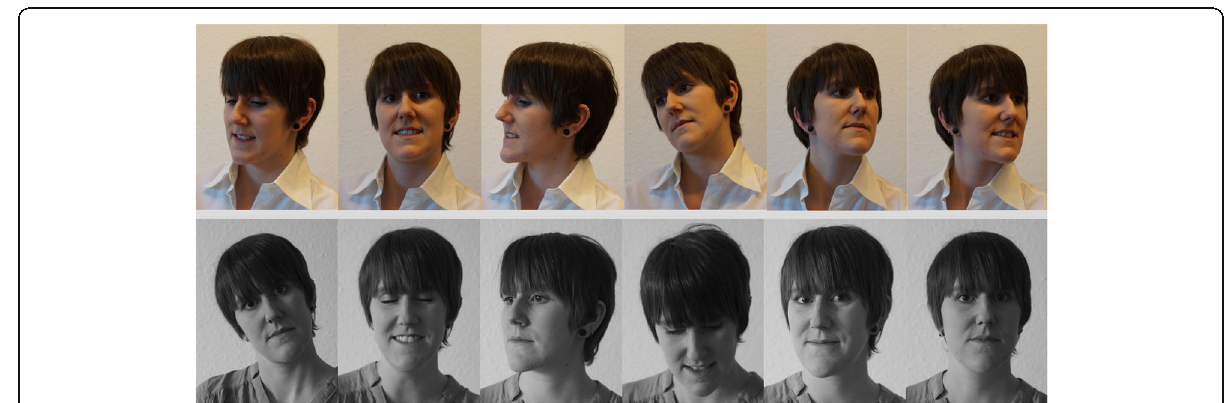
Fig. 11 Example of